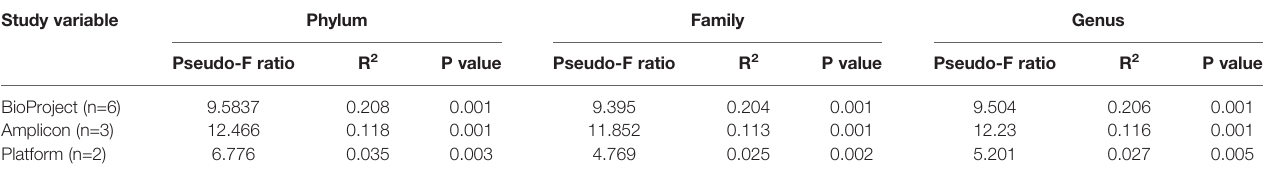
TABLE 5 | Study variable PERMANOVA analysis on Bray-Curtis distances of DD positive skin microbiota grouped at different taxonomic levels. Study